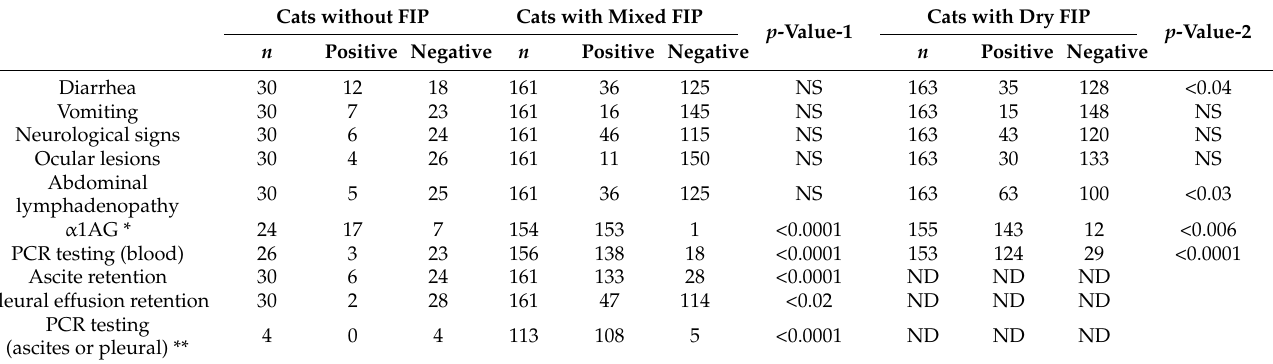
Table 2. Statistical comparison of categorical parameters between cats with and without